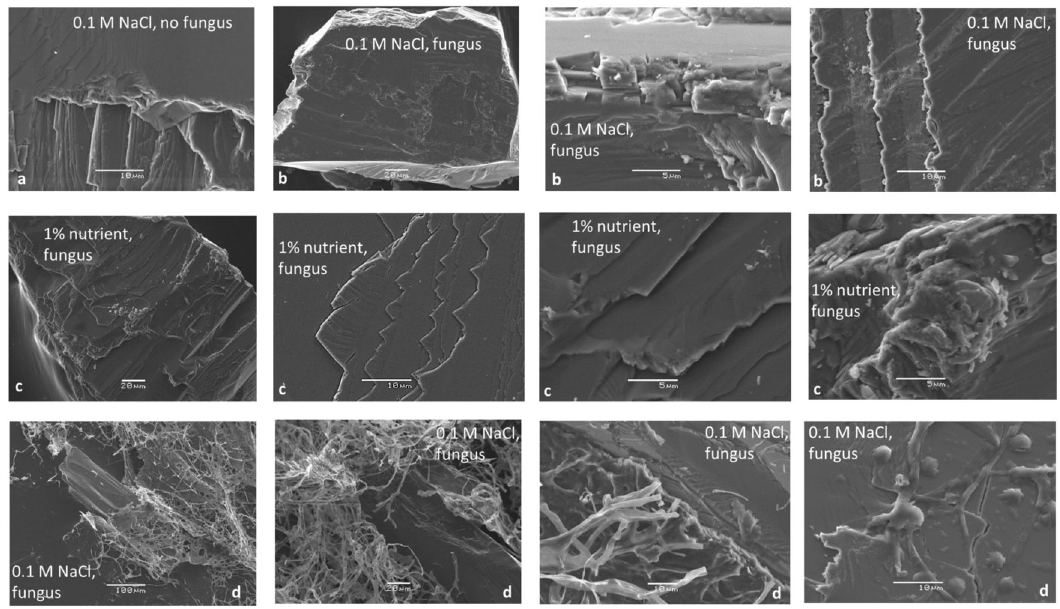
Fig. 5 Scanning Electron Microscope (SEM) images of diopside. SEM images of reacted diopside surfaces in the sterile electrolyte ( a ), live fungus in 0.1 M Na Cl ( b, d ), and in 1% nutrient media ( c, d